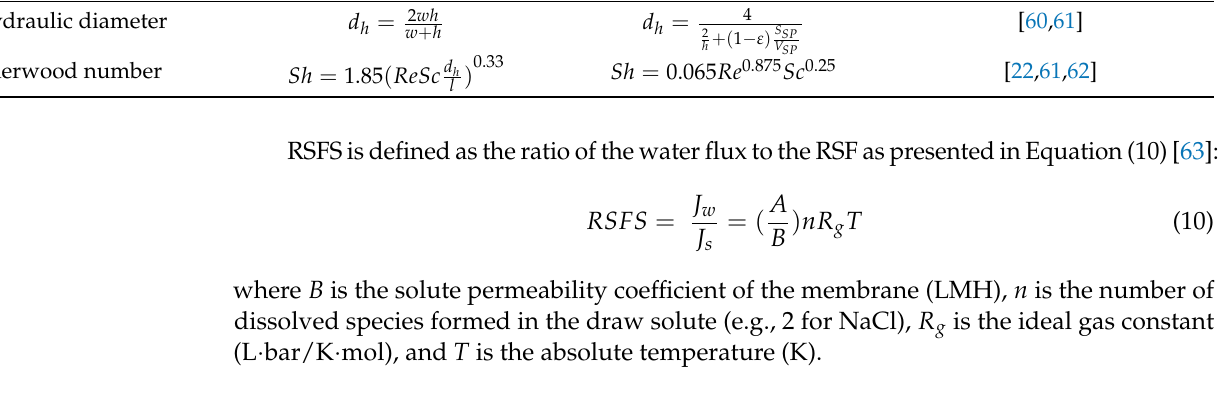
Table 2. Equations used to calculate the hydraulic diameter ( d h ) and Sherwood number ( Sh ). Without Spacer With Spacer Reference Hydraulic